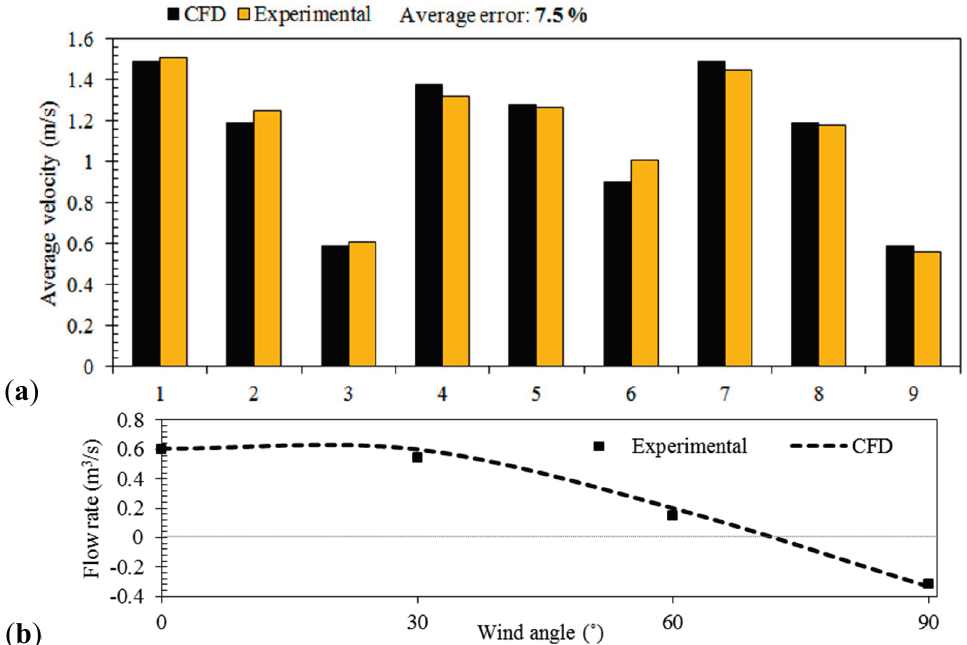
Figure 14. ( a ) Comparison between the prediction of the CFD and the measurement of the airflow speed at different points; ( b ) Effect of variation of wind direction on airflow